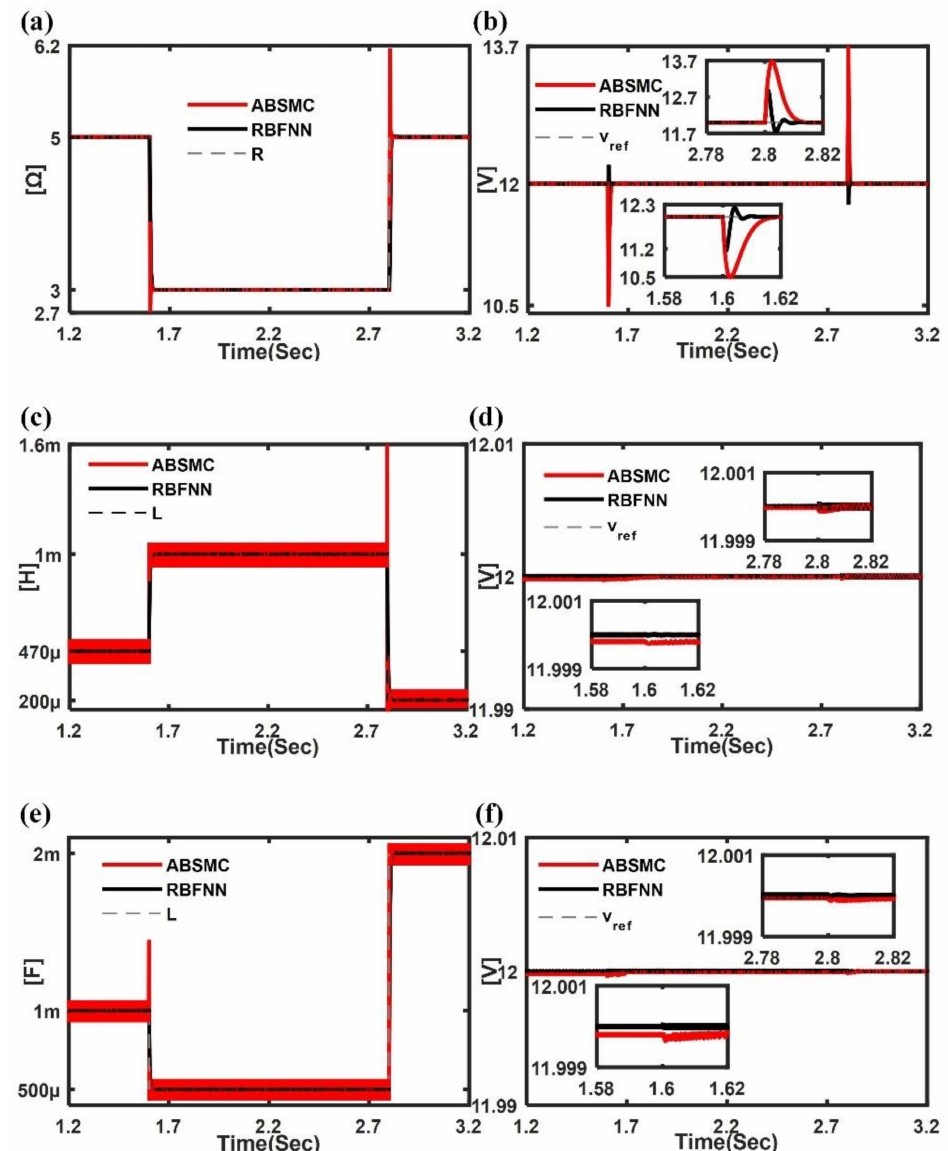
Figure 8. Simulation results under parametric variations: ( a ) Condition 5 R estimation ( b ) Condition 5 voltage response; ( c ) L estimation; ( d ) voltage response depending on L profile; ( e ) C estimation; ( f ) voltage response depending on C